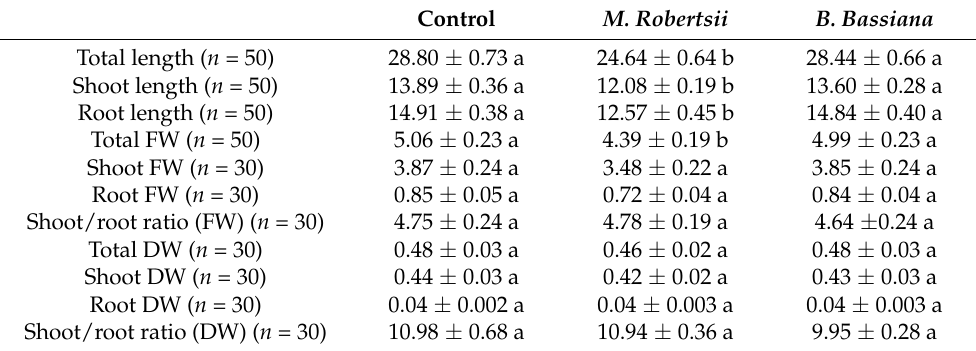
Figure 2. Growth response of Solanum tuberosum plants to nutrient medium (0.5 MS) with the addition of conidia from the entomopathogenic fungi M. robertsii (P-72) and B. bassiana (Sar-31) (1 × 10 6 spores/mL). Exposure—7 days. Table 1. Effect of treatment with EIPF on plant growth: length (cm) and weight (g). Values are the means ± SE. The same letters in a raw indicate insignificant differences between treatments (Dunn’s test, p > 0.05).